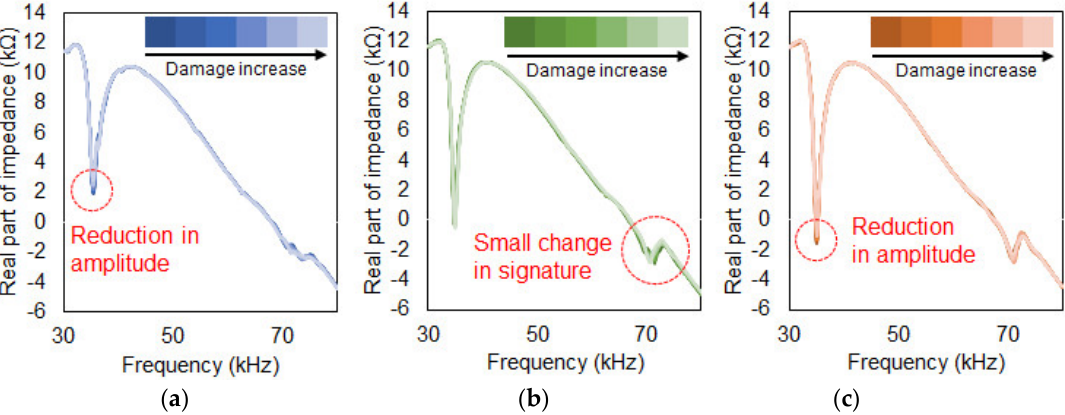
Figure 7. Progressive crack damage towards the PZT. ( a ) Conventional PZT attachment; ( b ) Steel wire PZT attachment; ( c ) Metal disc PZT attachment.